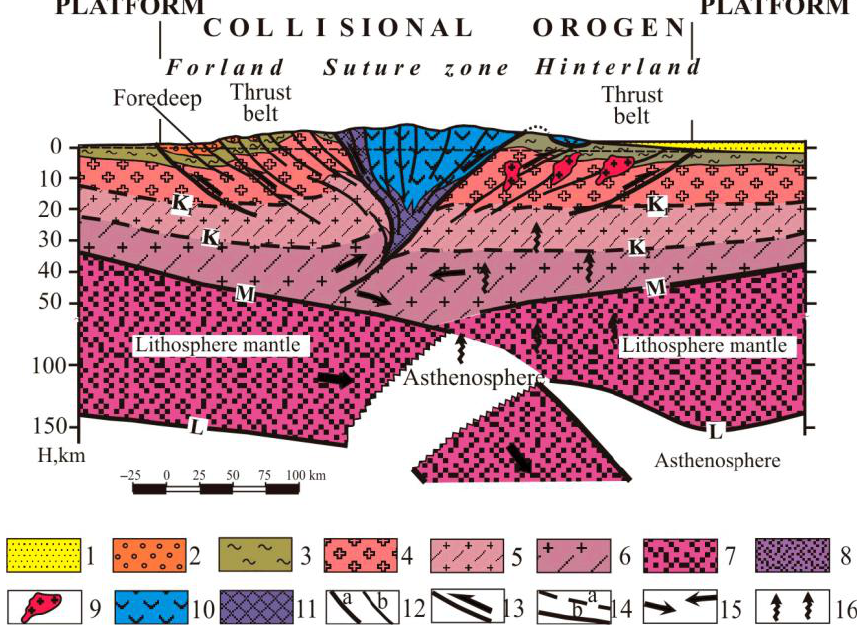
Figure 2. Model of a collisional orogen (Uralian type) [ 7 ]. Numbers 1–10 are structural and material units of the lithosphere: 1—weakly deformed sediments of the platform cover; 2—molasses; 3—lithified sediments of the ancient passive margin; 4—granite-gneiss layer; 5—middle crust; 6— lower crust; 7—lithospheric mantle; 8—riftogenic complexes; 9—granitoid plutons; 10—island arc complexes; 11—ophiolites; 12—faults (a-major, b-minor); 13—trends of thrust movements; 14— boundaries of radial stratification of the Earth’s crust, including. a—minor (F0—basement of the platform cover, K1—the basement of the upper crustal layer, K2—the basement of the middle crust); b—the basement of the Earth’s crust (the boundary of Mohorovichich); 15—trends in relative displacements of segments of the Earth’s crust; 16—trends of heat and mass transfer within the